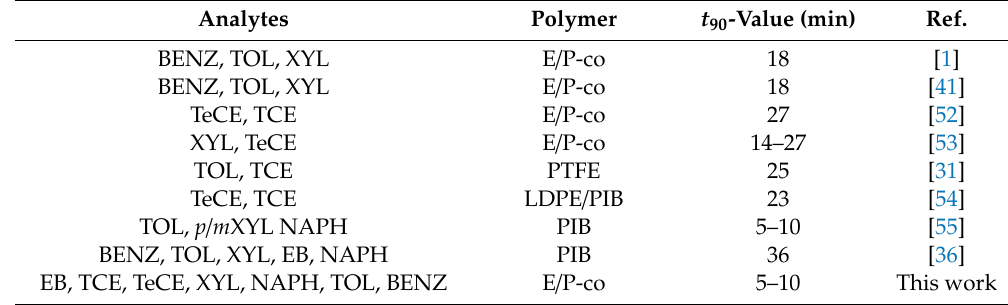
Table 2. Overview of response times ( t 90 -values) for detection of VOCs in water with the respective utilized polymer membrane.